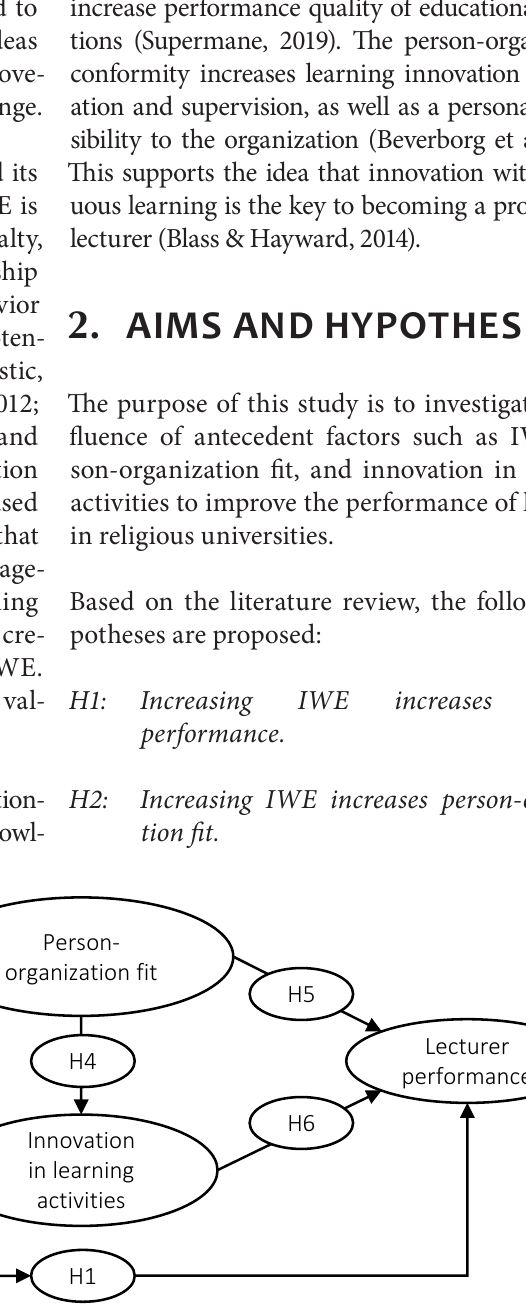
Figure 1. Research